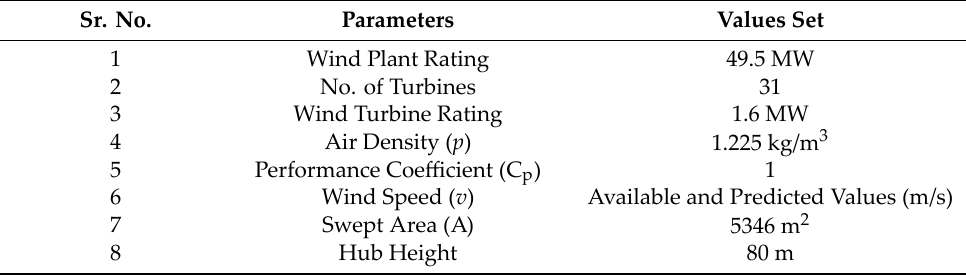
Table A1. Description of the Considered Wind Farm [46]. Sr.